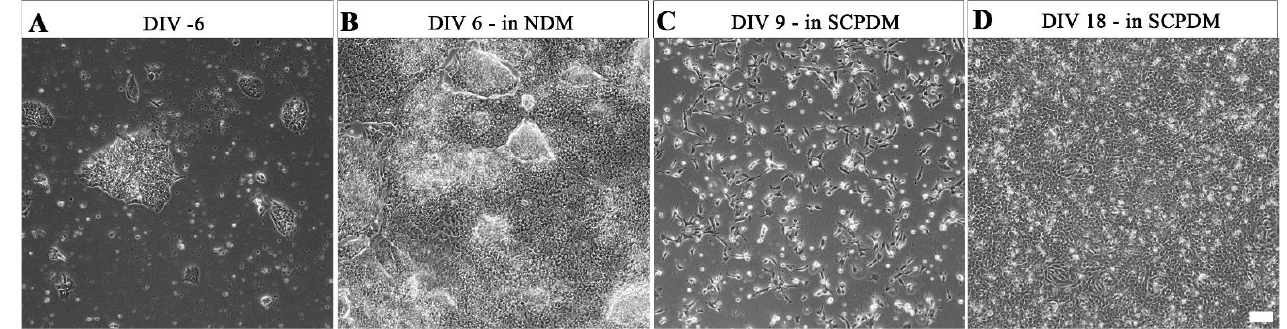
Figure 5. Phase contrast micrographs of morphological changes over the differentiation process in antibiotic free media from ( A ) hiPSCs; ( B ) at DIV 6 in NDM; ( C ) at DIV 9 in SCPDM; ( D ) hiPSC-SCPs at DIV 18 in SCPDM. hiPSCs ( A ) were plated on vessels coated with vitronectin, with the coating changed to Geltrex™ prior to the addition of NDM ( B – D ). Scale bar = 100 µm. NDM = neural differentiation medium; SCPDM = Schwann cell precursor differentiation medium.